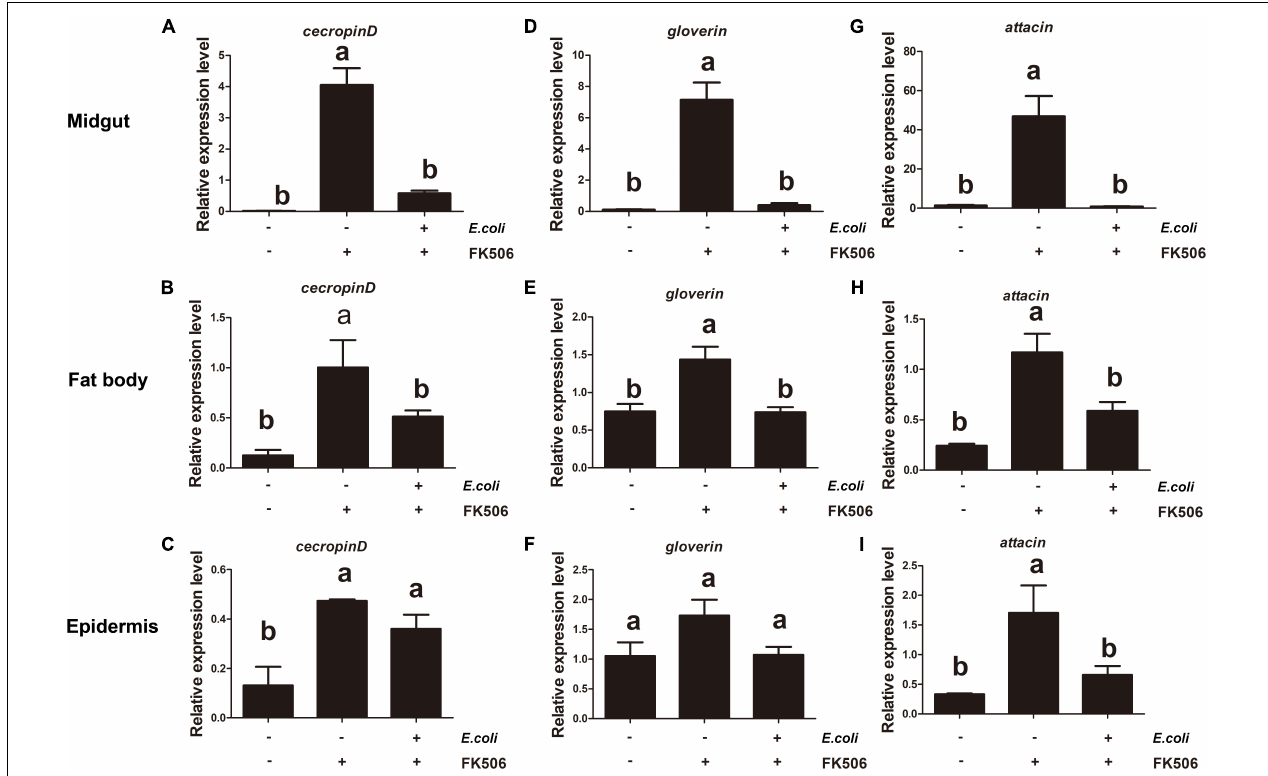
FIGURE 5 | Expression levels of endogenous antimicrobial peptides (cecropin D, attacin, and gloverin) in the midgut, fat body, and epidermis in response to Escherichia coli infection and E. coli + FK506 in fourth instar H. armigera after 1 h treatment. (A–C) Represent the relative expression levels of cecropin D in the migut, fat body, and epidermis, respectively. (D–F) Represent the relative expression levels of attacin in the migut, fat body, and epidermis, respectively. (G–I) Represent the relative expression levels of gloverin in the migut, fat body, and epidermis, respectively. Values shown are means and standard errors. Statistically significant differences for experimental comparisons are indicated by different small letters [analysis of variance (ANOVA) and Tukey’s test, P < 0.05; DPS7.05].